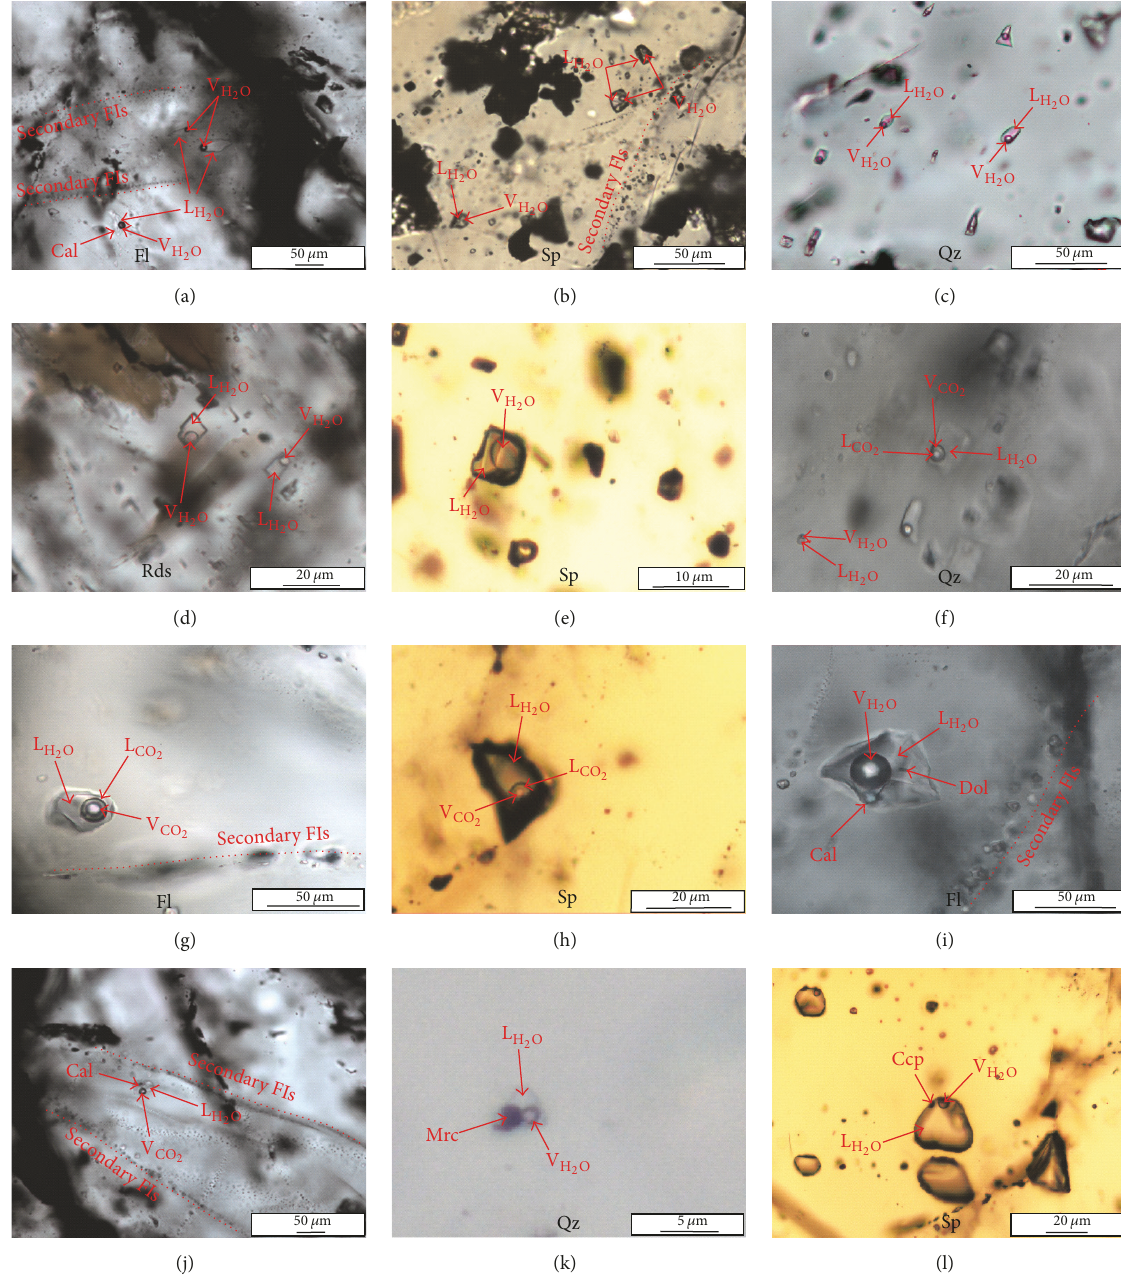
Figure 7: Photomicrographs showing the types and distribution of fluid inclusions observed in the Zhijiadi deposit. (a) Primary aqueous (W-type) inclusions coexisting with daughter mineral-bearing (S-type) inclusions in the main stage fluorite and these secondary W-type inclusions in a linear distribution penetrating crystal boundaries of fluorite. (b) Cluster of primary W-type inclusions in the main stage sphalerite and these secondary W-type inclusions penetrating crystal boundaries of sphalerite. (c) W-type inclusions clustered in the early stage quartz. (d) Primary W-type inclusions clustered in the main stage rhodochrosite. (e) Isolation of W-type inclusions from the main stage sphalerite. (f) Coexistence of aqueous-carbonic (C-type) inclusions and W-type inclusions in the early stage quartz crystals; C-type inclusions in the main stage fluorite (g) and sphalerite (h); (i) S-type inclusions in main stage fluorite (daughter minerals including calcite and dolomite), showing an obvious difference from the secondary W-type inclusions; (j) calcite-bearing S-type inclusions with CO 2 vapour bubble in the main stage fluorite; (k) marcasite-bearing S-type inclusions in the early stage quartz; (l) chalcopyrite-bearing S-type inclusions in the main stage sphalerite. V CO 2 , vapour CO 2 ; L CO 2 , liquid CO 2 ; V H 2 O , vapour H 2 O; L H 2 O , liquid H 2 O; Qz, quartz; Rds, rhodochrosite; Fl, fluorite; Sp, sphalerite; Cal, calcite; Dol, dolomite; Mrc,